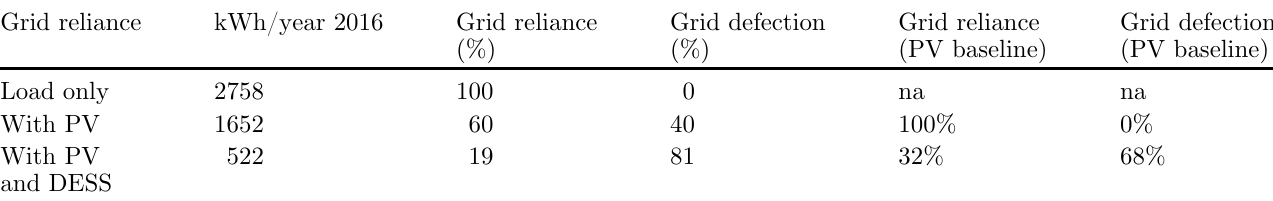
Table 3. Josh ’ s House value of exported PV energy – impact of DESS [8]. Excess PV production